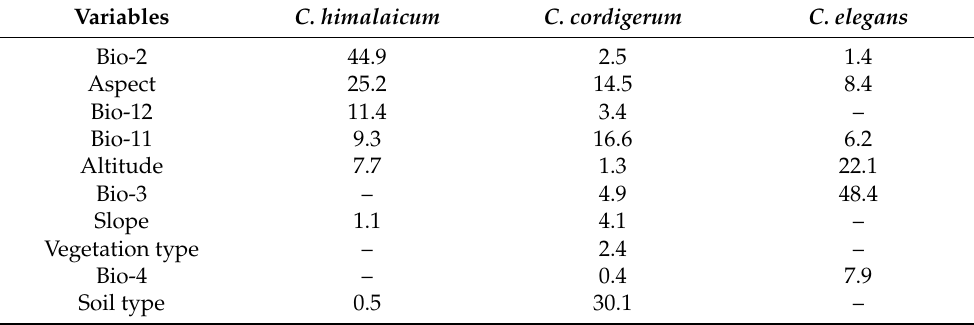
Table 1. Environmental variable contributions showing their respective percent